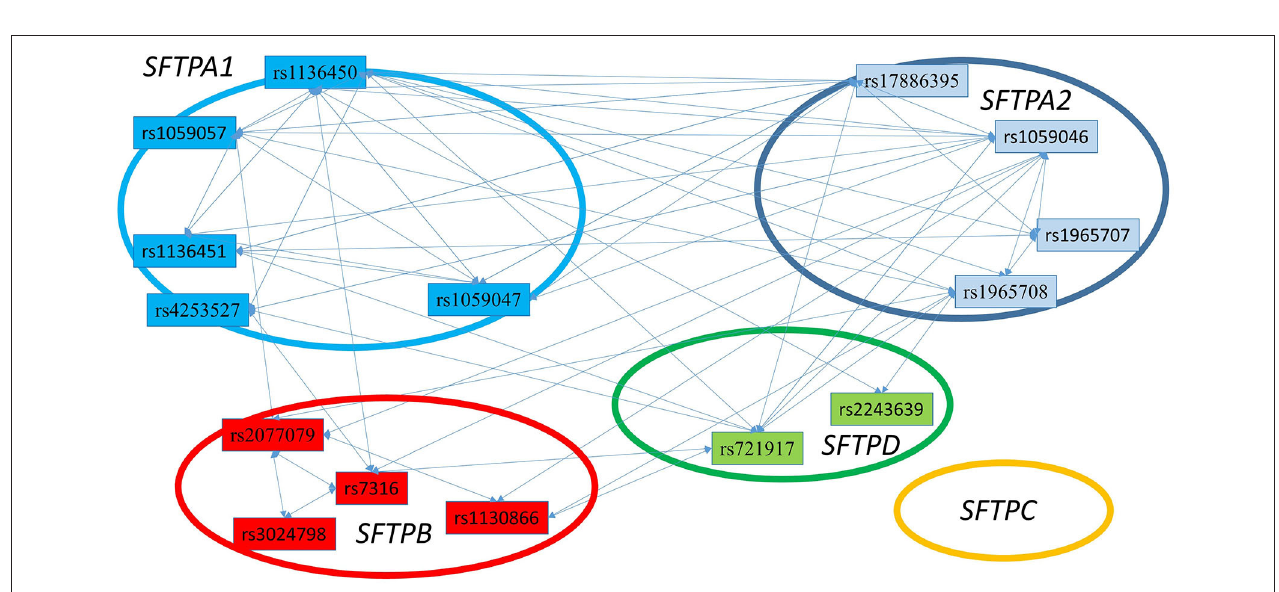
FIGURE 3 | The two SNP interaction in RDS susceptibility. Associations between RDS and the two SNP-SNP interactions are shown. The star marks the SFTPA2 SNP shown to associate with RDS by itself. (A) depicts the two SNP-SNP intergenic and intragenic interactions of the hydrophilic SP genes associated with RDS. (B) depicts the two SNP-SNP intergenic and intragenic interactions of the hydrophobic SP genes associated with RDS.